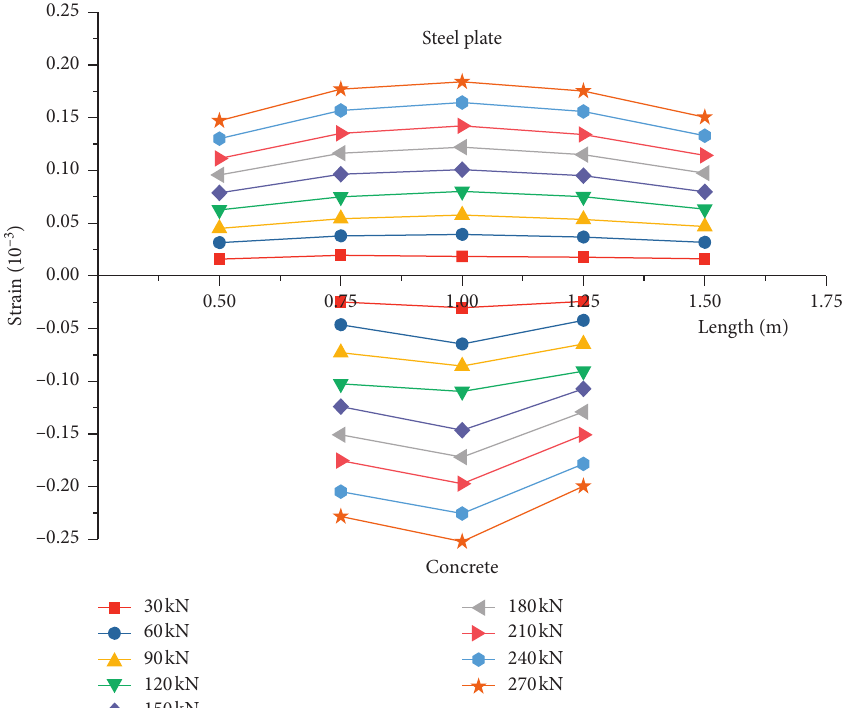
Figure 16: Strain distribution of SC-M1 in flexural experiment.